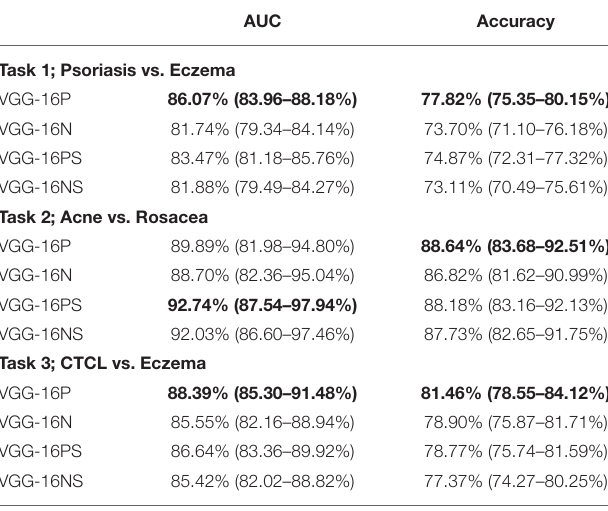
TABLE 3 | Performance of all VGG-16